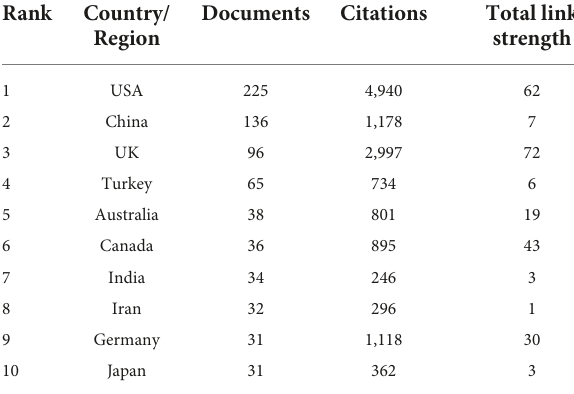
TABLE 2 Top 10 countries/regions on cesarean section recovery.